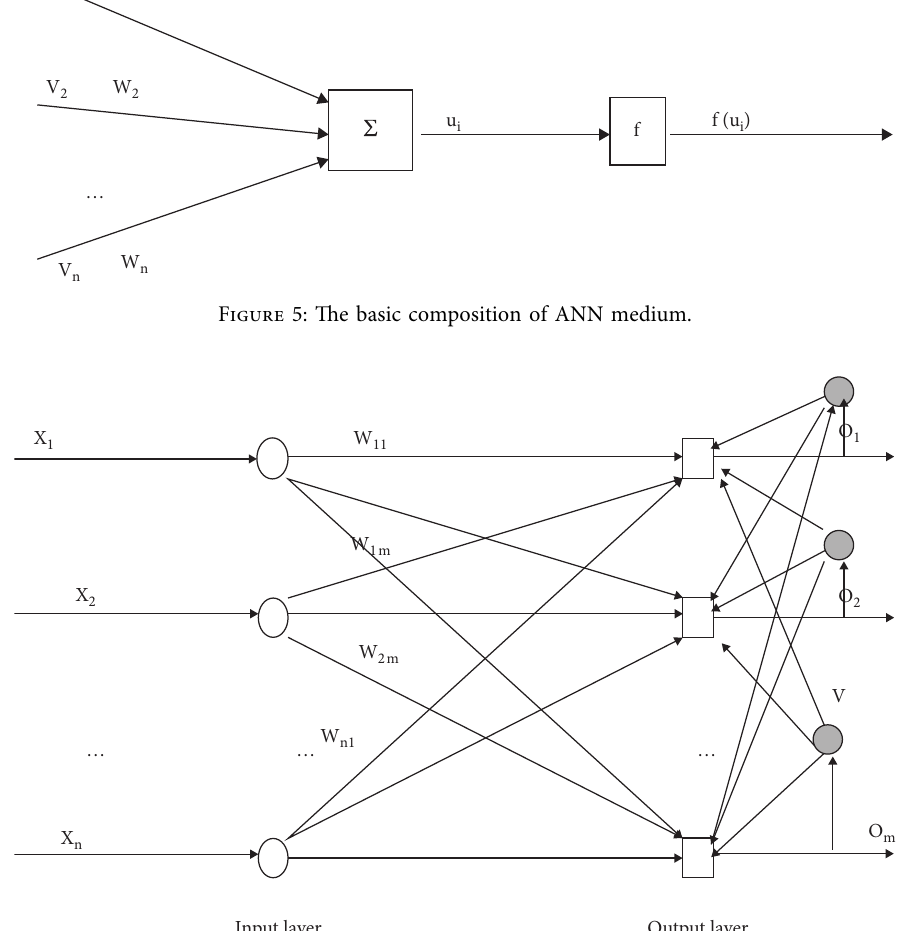
Figure 6: Simple single-stage horizontal feedback network